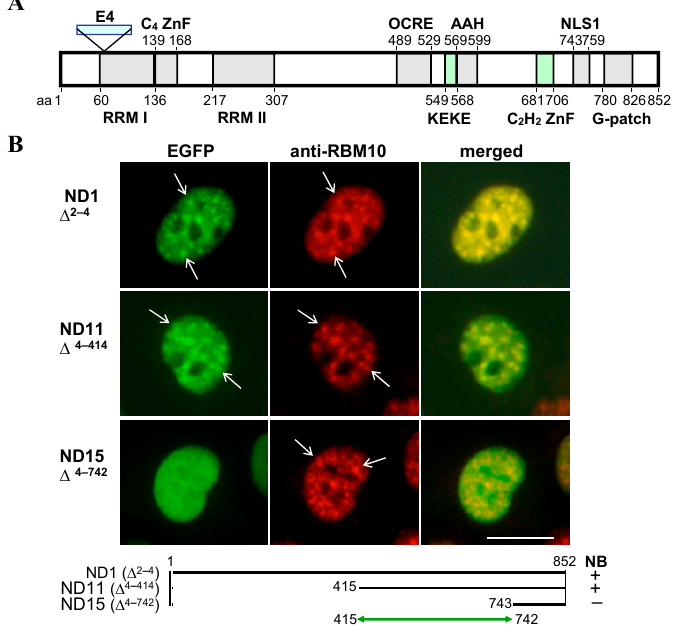
Figure 1. RBM10 targets NBs. ( A ) Structure of the 852-aa isoform of RBM10. RRMs I and II: RNA recognition motifs I and II, respectively; E4: a 78-aa region encoded by exon 4 and expressed in